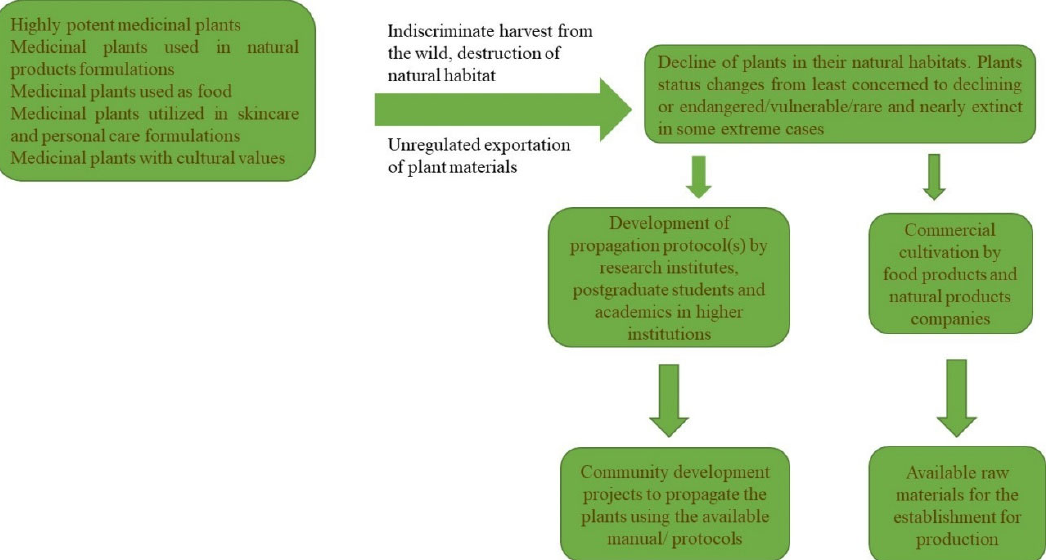
Figure 2. The path leading to the propagation of South African indigenous and naturalized medicinal plants.